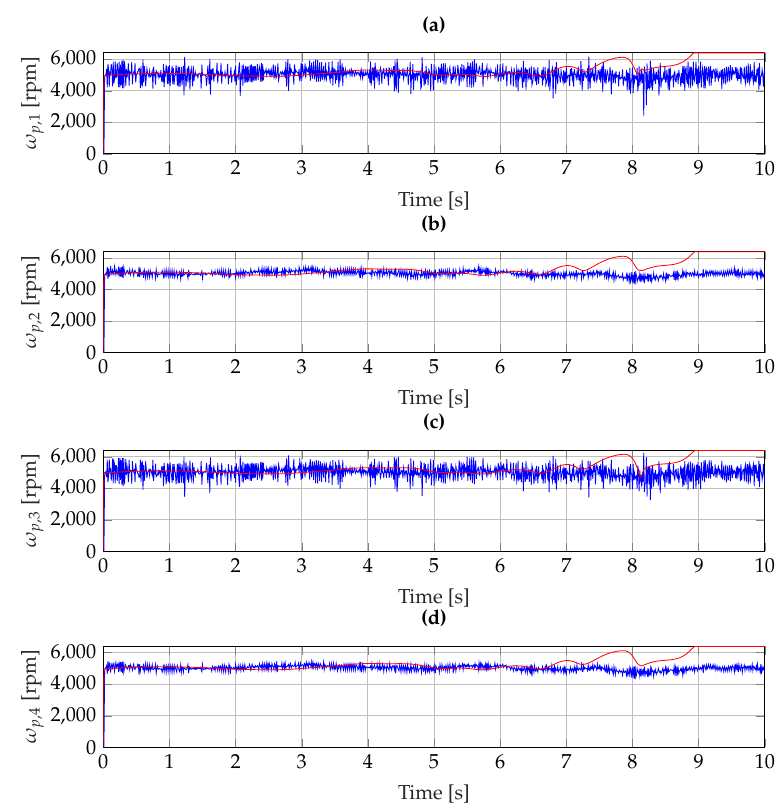
Figure 9. Propulsion angular velocities of robust (blue) and non-robust controller (red): ω p ,1 ( a ), ω p ,2 ( b ), ω p ,3 ( c ), ω p ,4 ( d ).